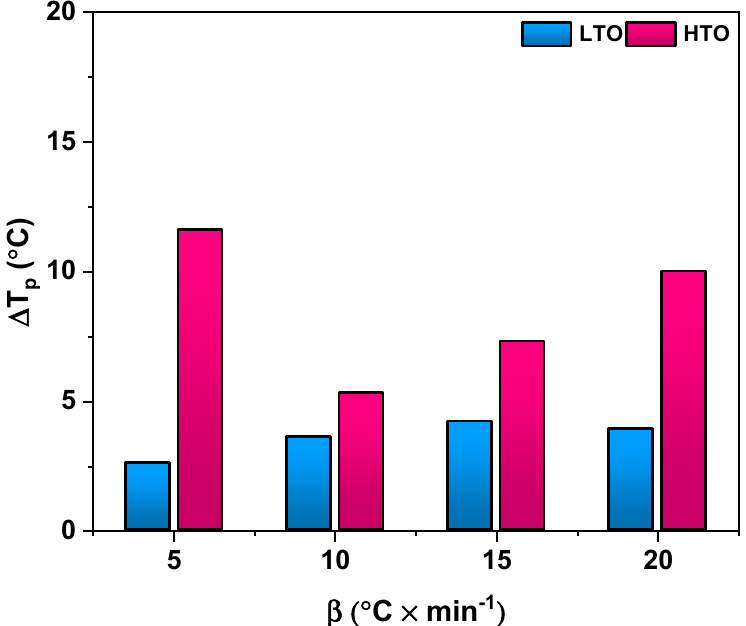
Figure 2. Differences between the peak temperatures ( ∆ Tp) of non-catalytic and catalytic peat oxidation for LTO and HTO regions at different heating rates obtained from thermogravimetric and differential thermogravimetric analysis.